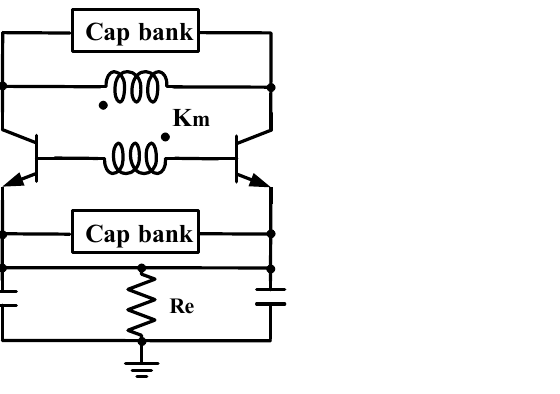
Figure 7. Schematic of the transformer-based VCO with third-harmonic extraction technique.